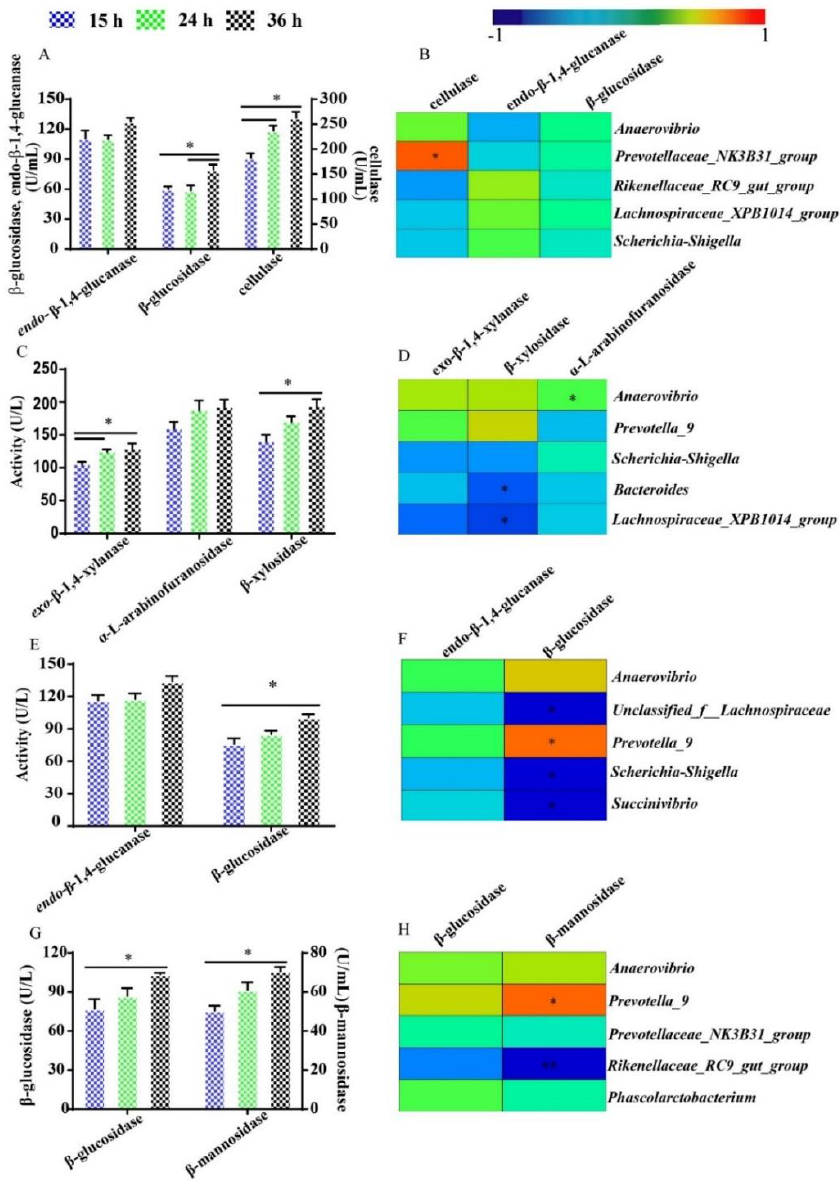
Figure 6. The activities of endo- β -1,4-glucanase, cellulase, and β -glucosidase ( A ), Spearman’s correla- tion between these enzymes and the top five bacteria at 15, 24 and 36 h during cellulose fermentation ( B ). The activity of exo- β -xylanase, α -L-arabinofuranosidases and β -xylosidase ( C ), Spearman’s cor- relation between these enzymes and the top five bacteria at 15, 24 and 36 h during arabinoxylan fermentation ( D ). The activity of endo- β -1,4-glucanase and β -glucosidase ( E ), Spearman’s correlation between these enzymes and the top five bacteria at 15, 24 and 36 h during β -glucan fermentation ( F ). The activity of β -glucosidase and β -mannosidase ( G ), Spearman’s correlation between these enzymes and the top five bacteria at 15, 24 and 36 h during glucomannan fermentation ( H ). All data were analyzed by the one-way ANOVA with Tukey’s post-hoc test and presented as the mean value ( n = 9, * mean p < 0.05; ** means p < 0.01; Con, control; Cel, cellulose; Arx, arabinoxylan; β -Glu, β -glucan; Glu,